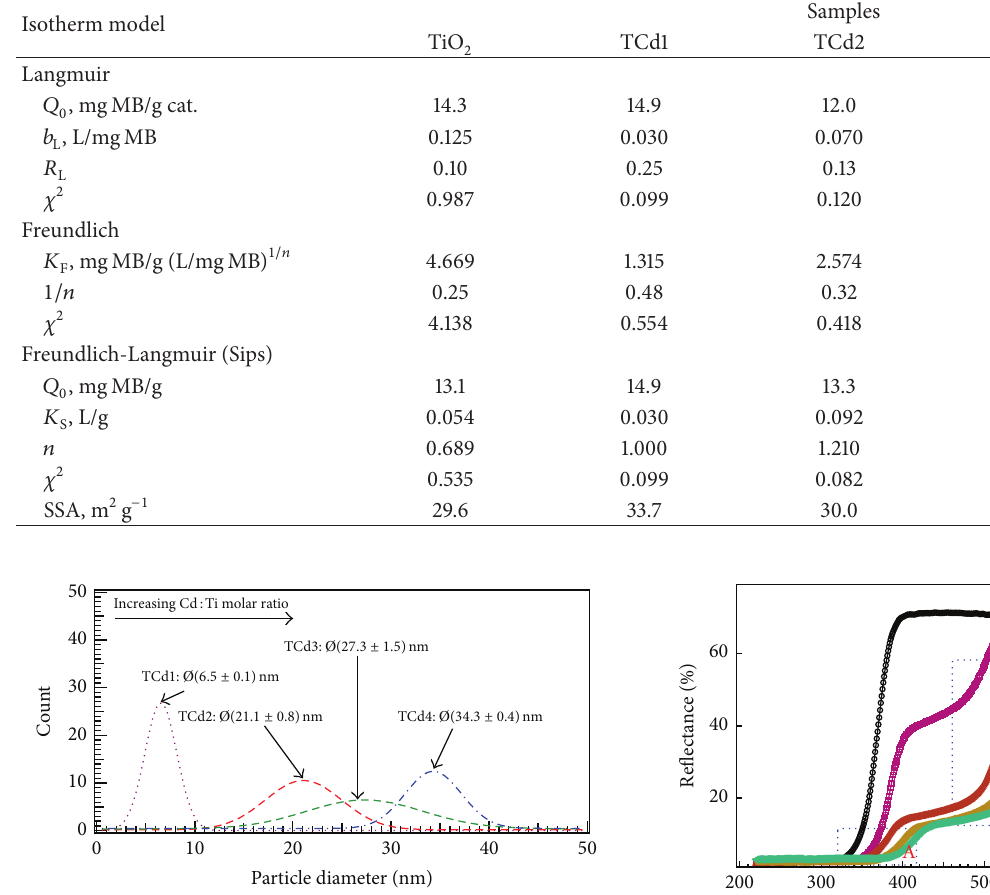
Figure 4: Evolution of particle size with increase in Cd:Ti molar ratio.